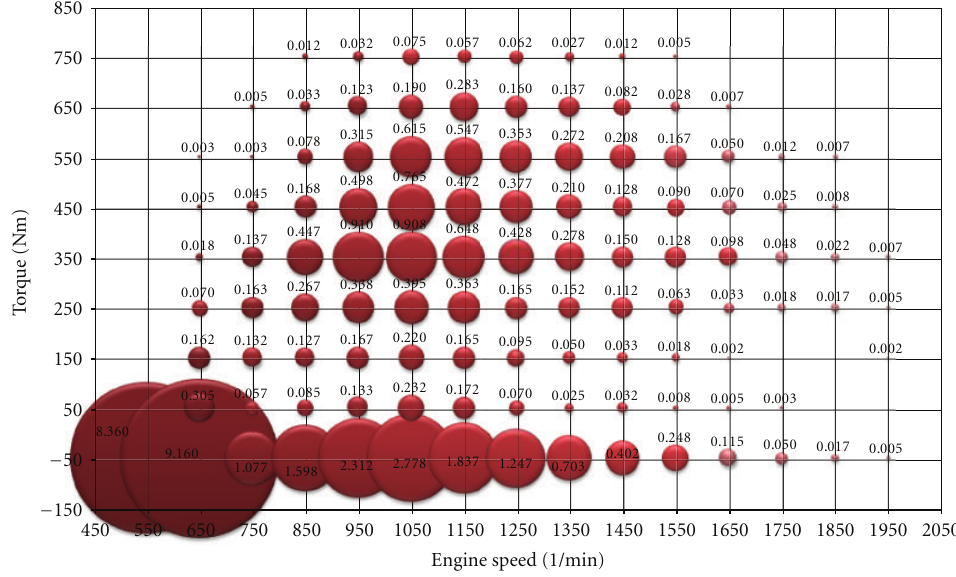
Figure 1: Duty cycle of chosen engine on an intracity bus